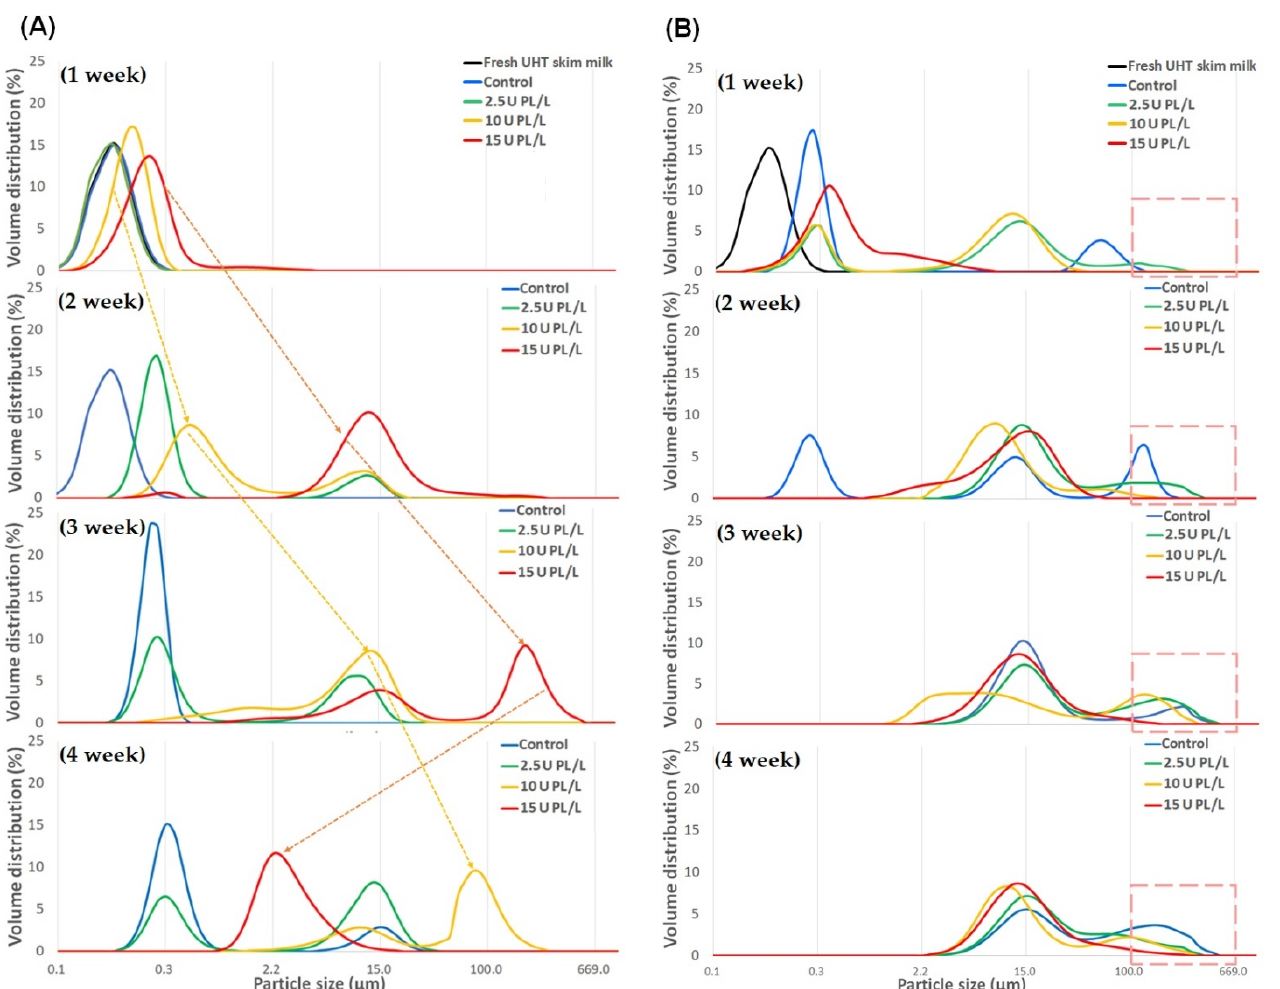
Figure 1. Changes in particle size distribution of UHT skim milk containing 2.5, 10, and 15 U PL/L during storage at ( A ) 23 °C and ( B ) 37 °C. UHT, ultra-high temperature; PL, plasmin.